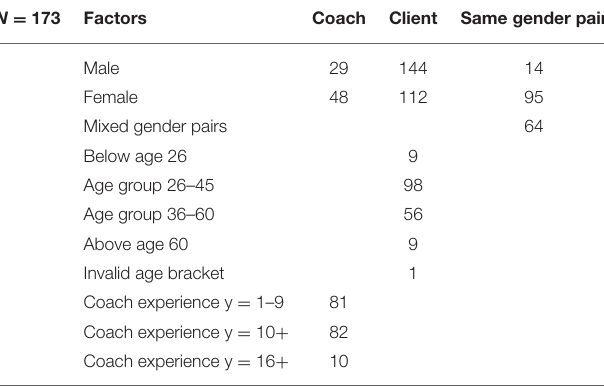
TABLE 2 | Overview of demographic factors as predictors, N =